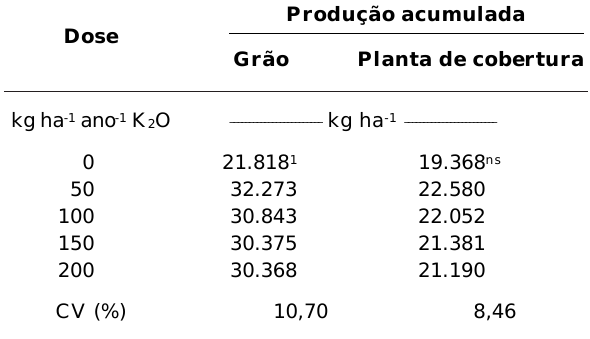
Figura 1. Rendimento relativo de grãos de soja, milho e sorgo de acordo com a disponibilidade de potássio no solo e estabelecimento do nível de